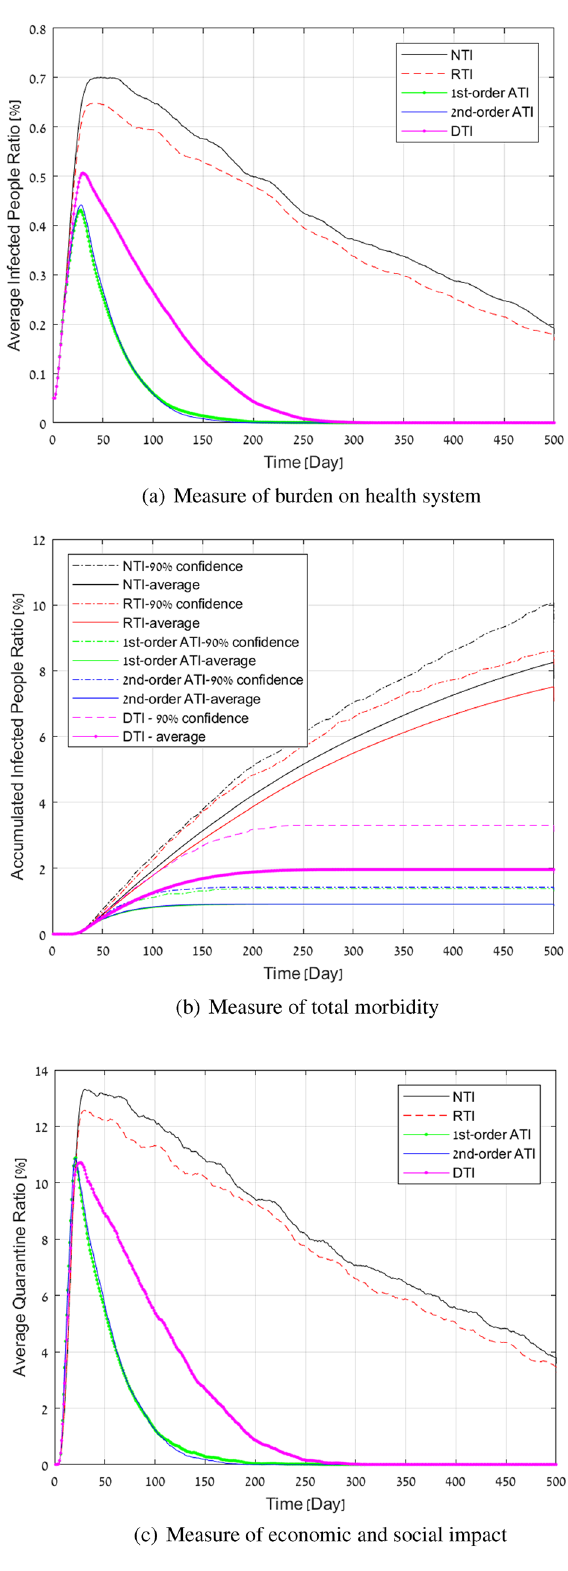
Figure 2. Simulation results for a COVID-19 outbreak in a population of 100,000 people, and testing capacity of 0.3% per